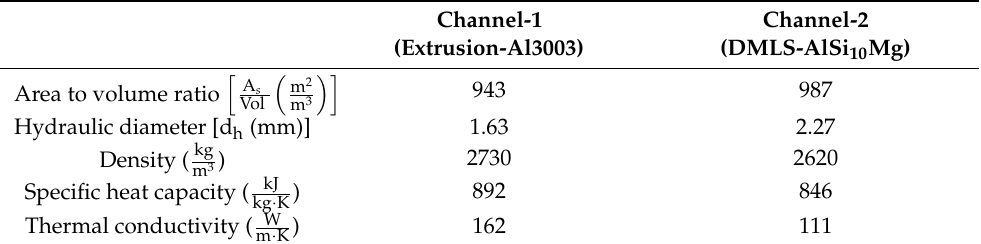
Table 1. Geometrical characteristics and material properties of the channels.